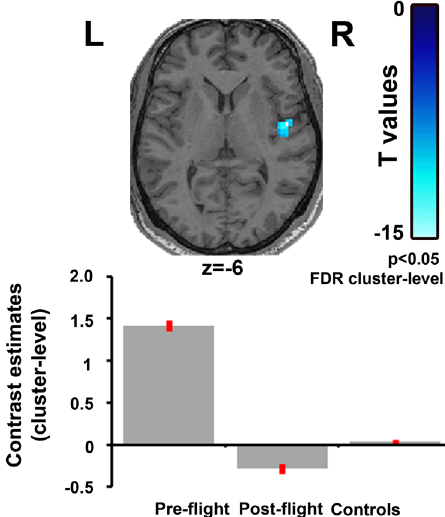
Fig. 3 The fi gure shows decreased connectivity strength in the right insula, a critical region of the vestibular cortex, when comparing post- fl ight to pre- fl ight in a cosmonaut. The bars represent the average connectivity strength in the respective cluster with 90% con fi dence interval (whiskers) for the pre- fl ight and post- fl ight scan. The statistical map is rendered on the normalized MRI scan of the cosmonaut (axial view) (from, 60 used with